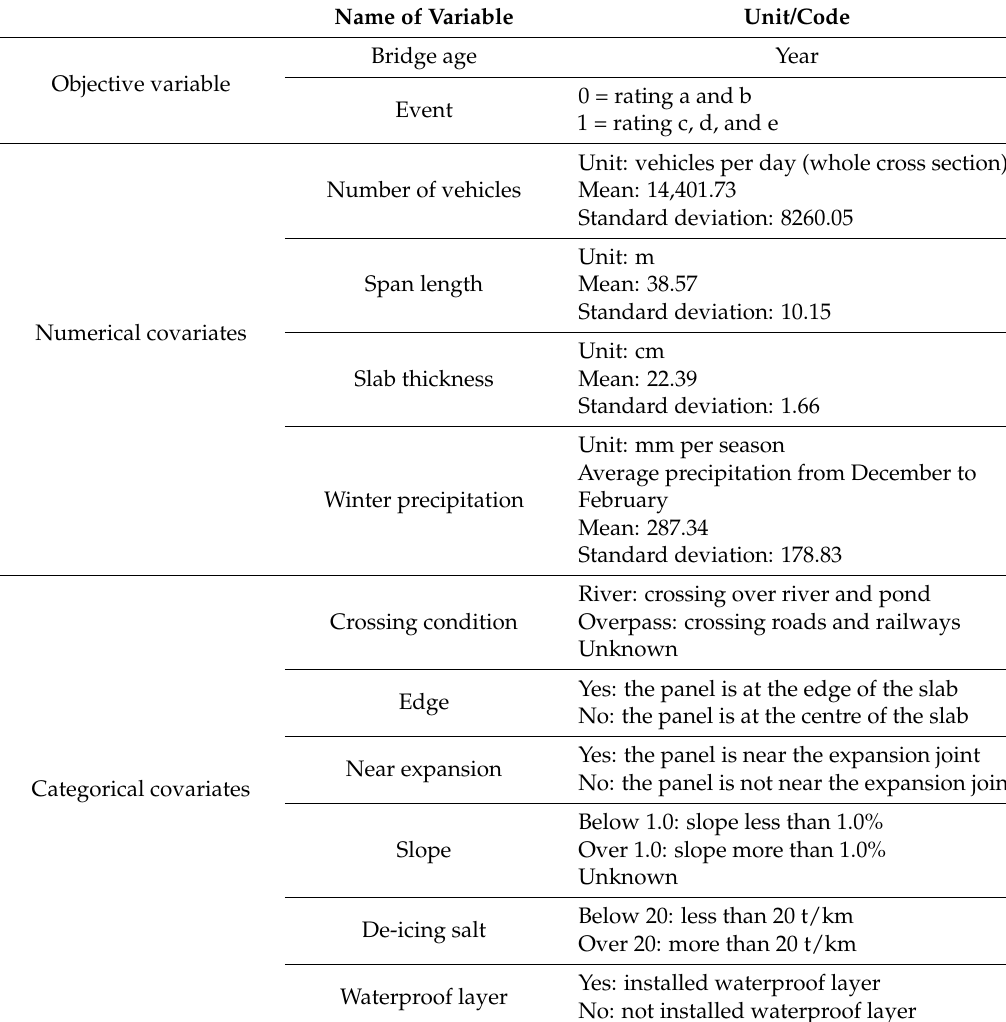
Table 2. Variables used in analysis in East